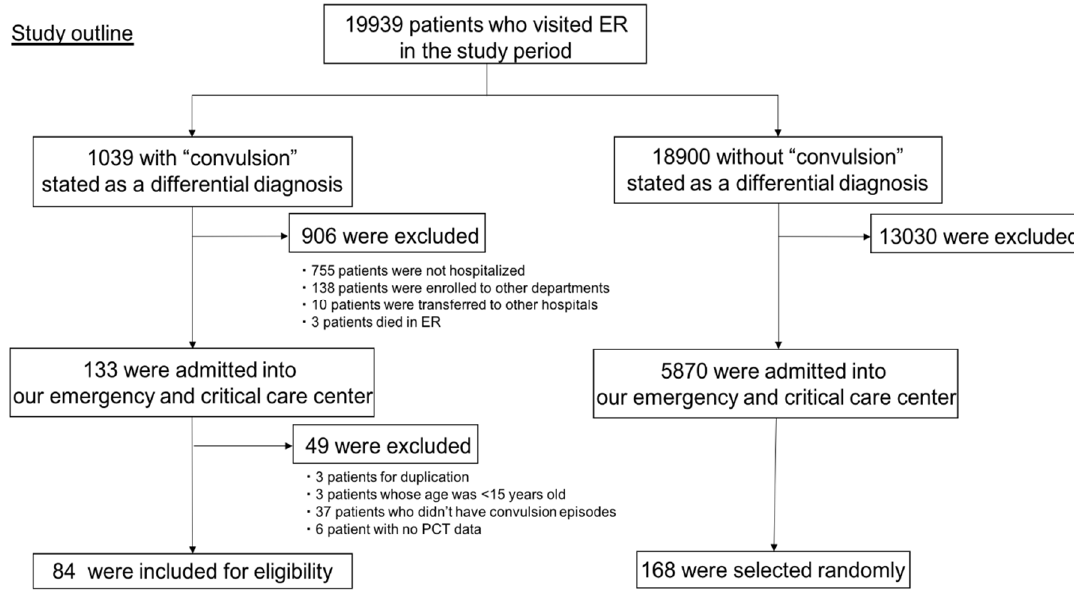
Figure 1. Outline of patient selection.